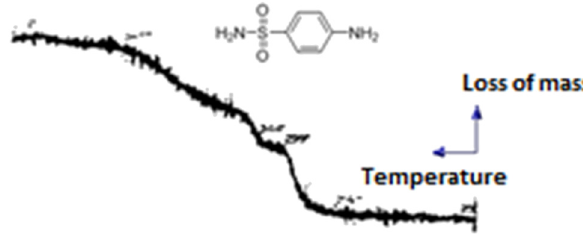
Figure 12: TG analysis of the sulfanilamide ligand [ 56 ] , ( NH ) , at a heating rate of 2 C 6 H 4 SO 2 NH 2